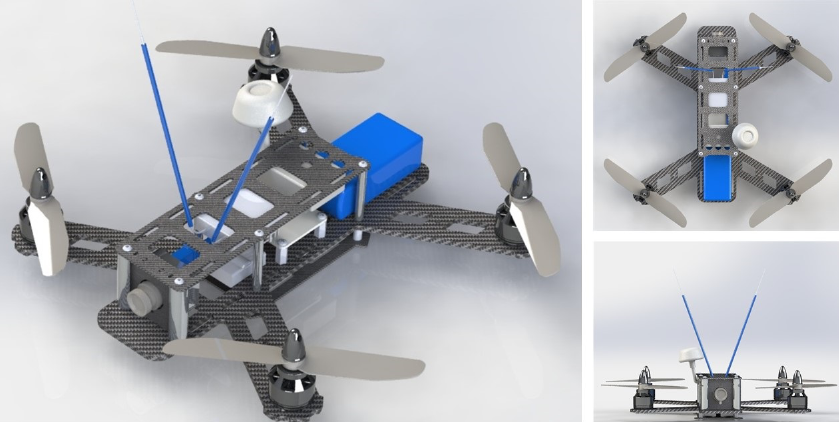
Figure 3. Top ( top-left ), isometric ( top-right ) and front ( bottom ) views of the 3D model of the quadrotor obtained in a Computer-Aided Design (CAD) software.